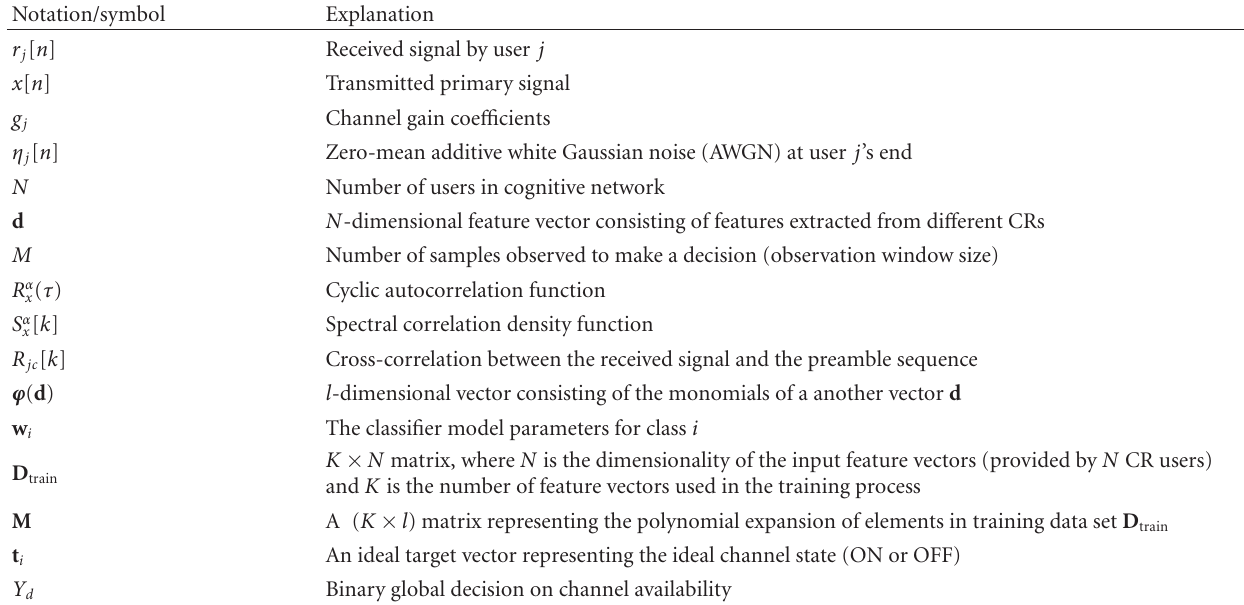
Table 1: List of